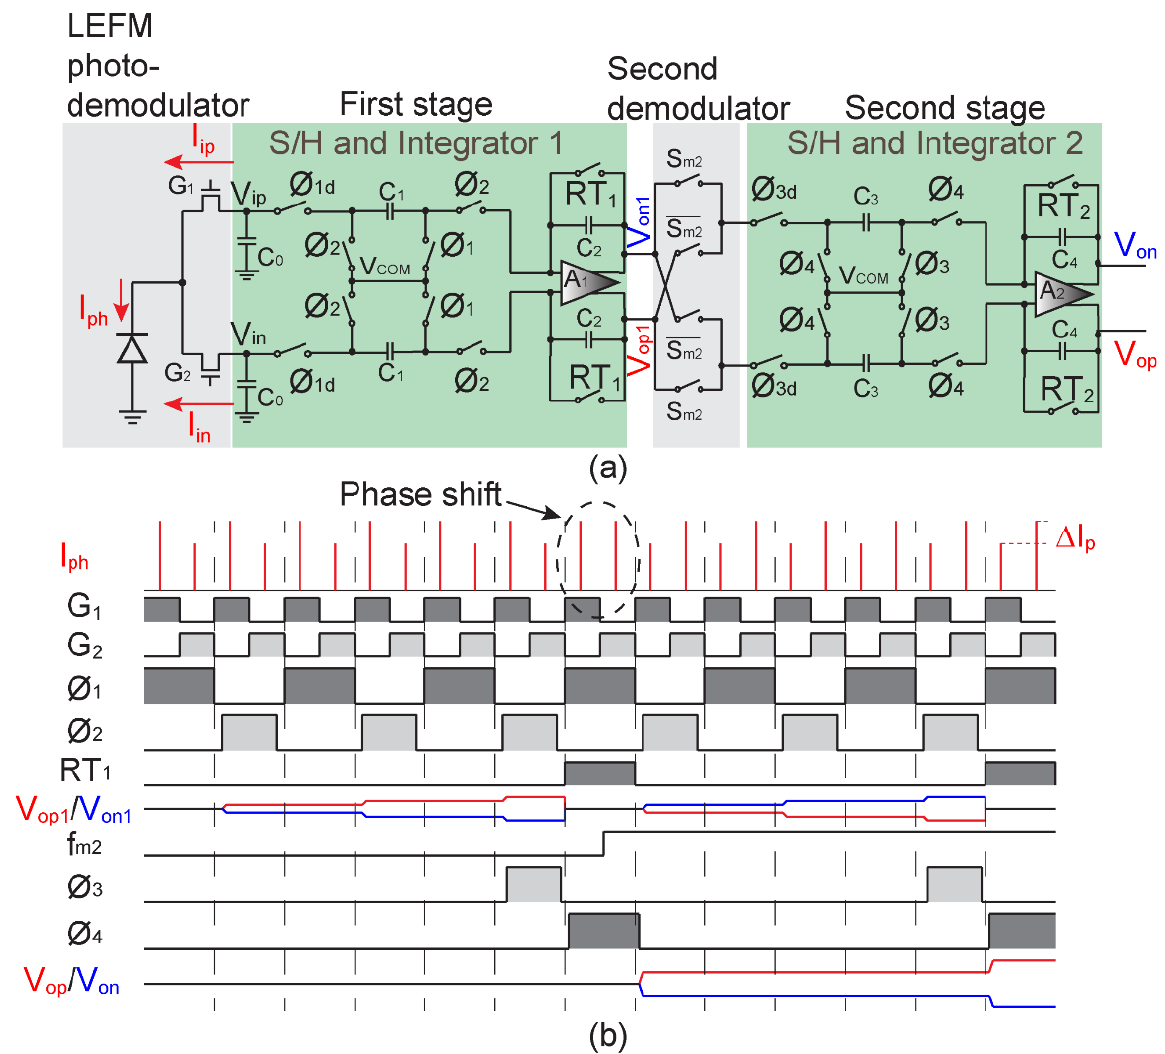
Figure 6. Schematic design of the SRS signal lock ‐ in amplifier: ( a ) Schematic diagram. ( b ) A timing diagram for the circuit operation.